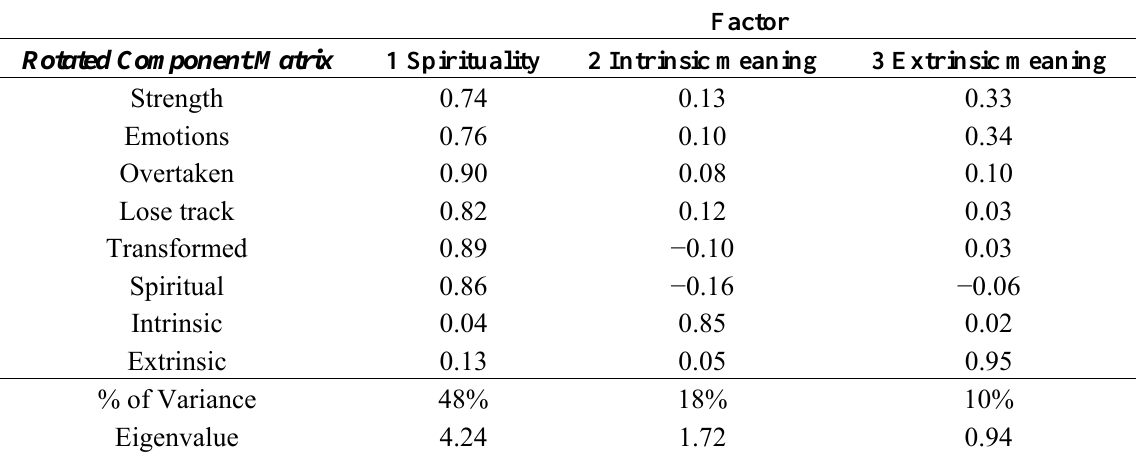
Table 1. Factor analysis of the pooled questionnaire data.